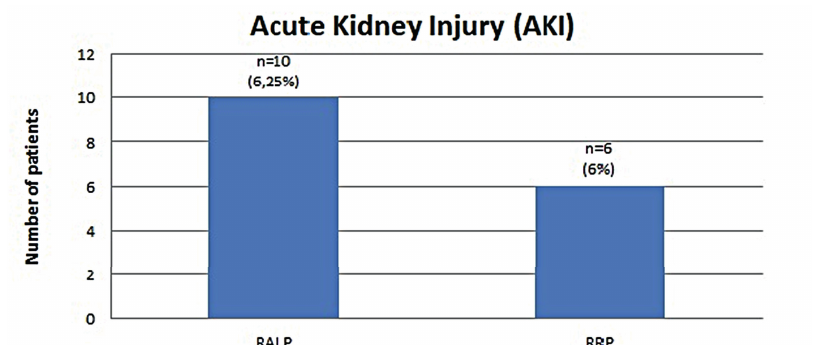
Figure 2 - Incidence of patients with AKI in both